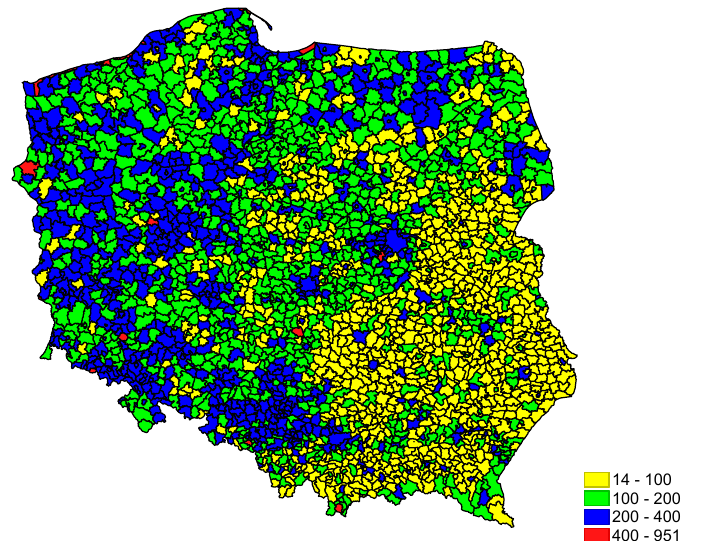
Figure 1. Total amount of generated waste in kg . (per ∙ year) − 1 on the territory of municipalities in Poland in 2013–2016.